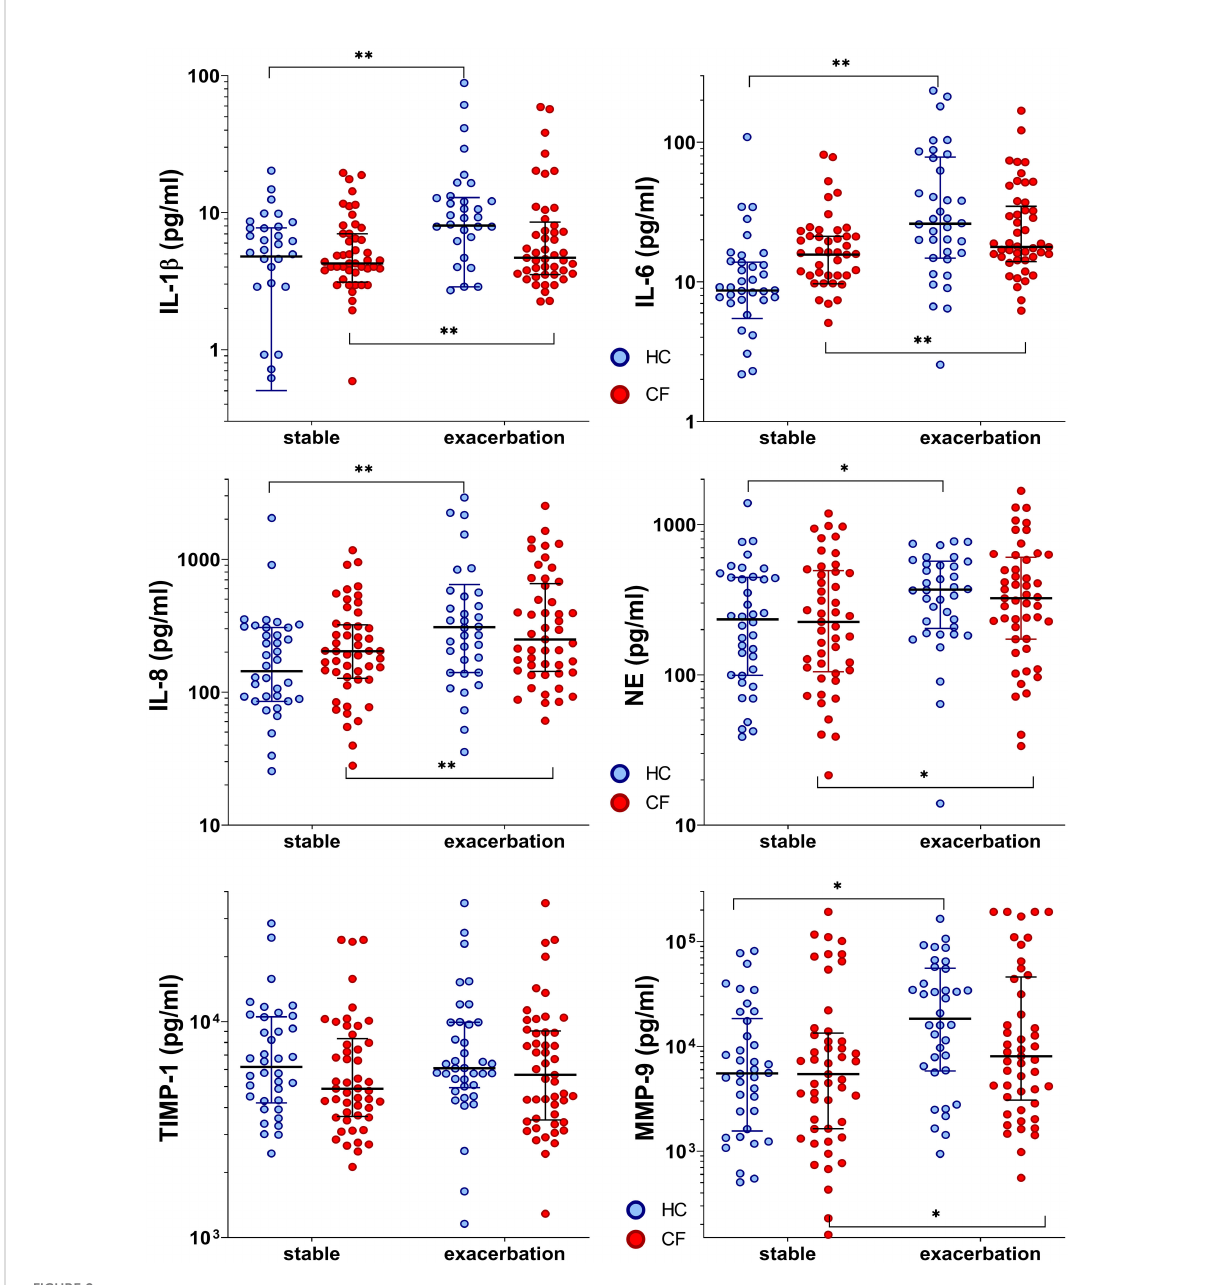
FIGURE 2 In fl ammatory markers in healthy controls and people with CF during stable phase and exacerbation. Statistical signi fi cance levels are displayed as follows: *p <0.05,